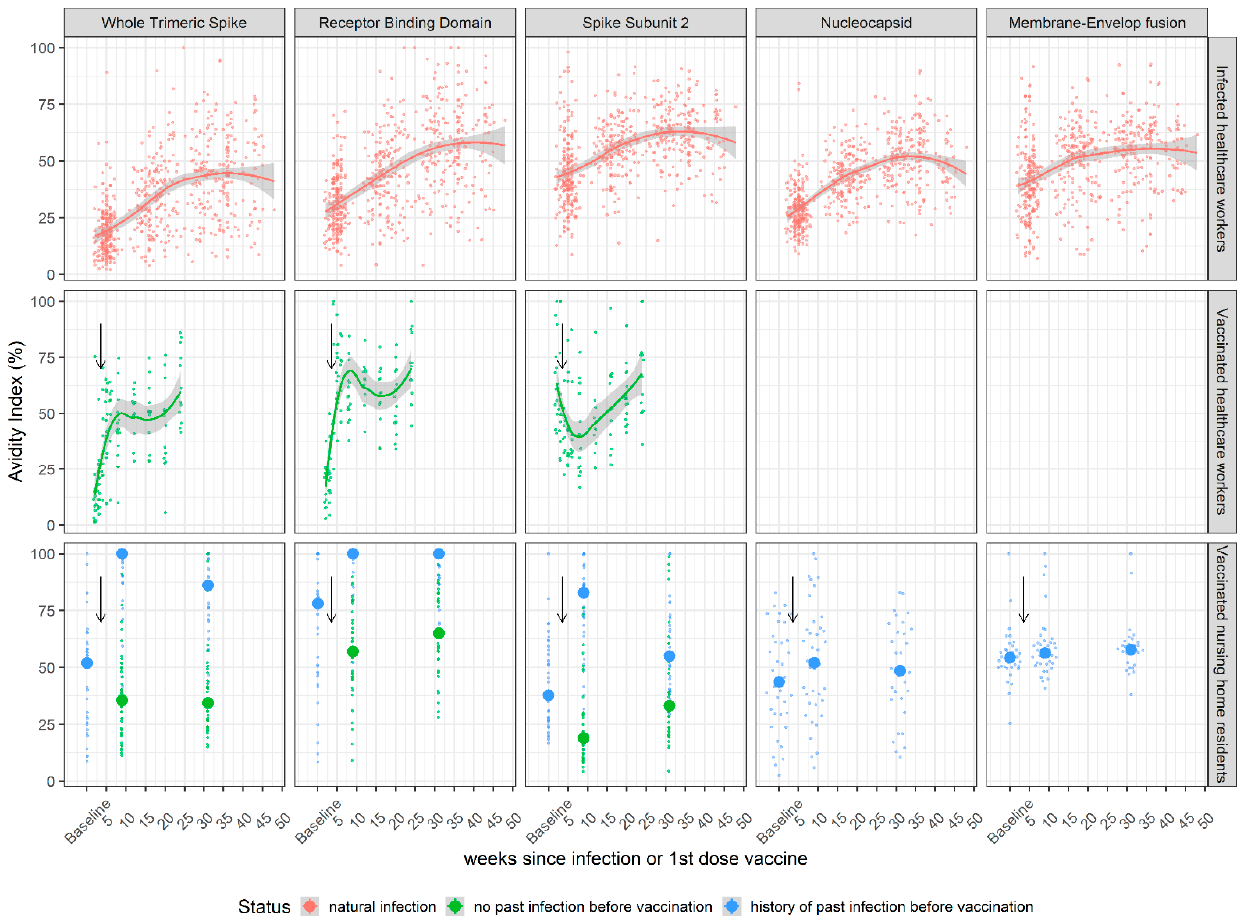
Figure 2. Kinetics of IgG avidity following SARS-CoV-2 infection or vaccination with BNT162b2. IgG avidity to five SARS-CoV-2 antigens was measured in serum samples using a bead-based multiplex Luminex assay. (First row) Healthcare workers from hospitals in Strasbourg and Paris were followed longitudinally following PCR-confirmed SARS-CoV-2 infection. (Middle row) Healthcare workers from a hospital in Orl é ans were followed longitudinally after receiving two doses of Pfizer BNT162b2 vaccine. (Bottom row) Residents of a nursing home in Dublin were followed after receiving two doses of Pfizer BNT162b2 vaccine. Individuals with “history of past infection” correspond to individuals with recorded SARS-CoV-2 infection before vaccination and are represented with blue dots. Individuals with no history of past infection are in green. Time is denoted as weeks post-vaccination. Thicker dots represent the median of each group. Black arrows indicate the date of the second vaccine injection. The avidity indexes of anti-Nucleocapsid and anti-Membrane-Envelope IgG are not shown for unvaccinated individuals, as well as data points for anti-spike (whole spike, RBD and S2) IgG of nursing home residents with no prior history of infection before